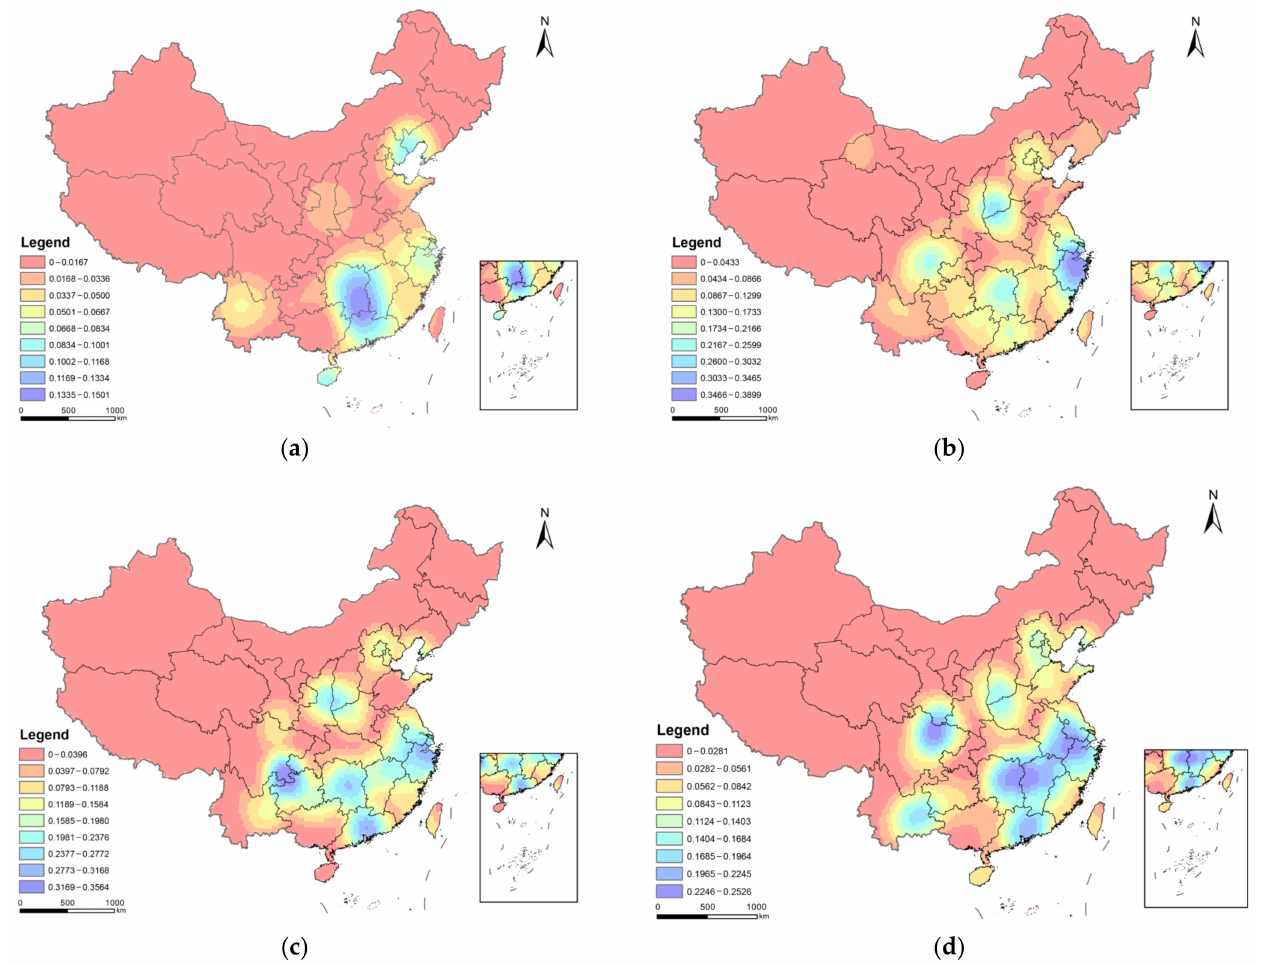
Figure 4. Efficiency of NSAs kernel density analysis results. ( a ) 2003; ( b ) 2008; ( c ) 2013; ( d )